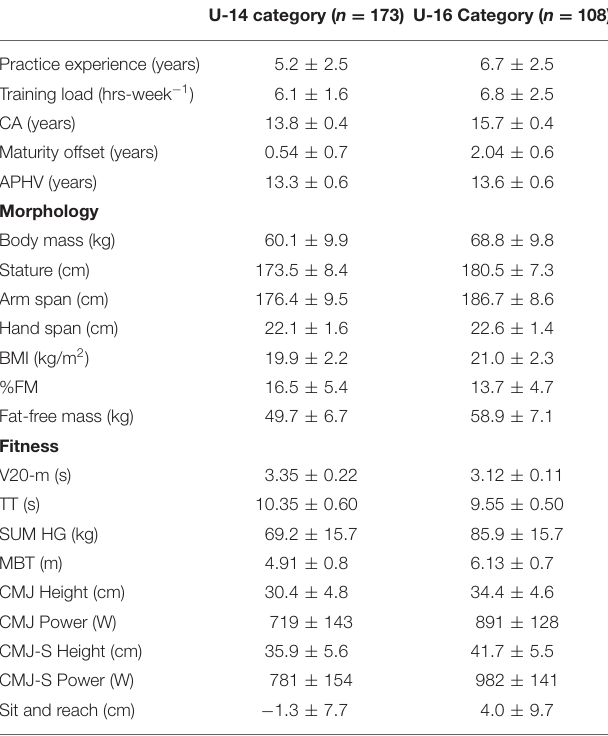
TABLE 2 | Descriptive statistics (mean ± SD) for training experience, maturational parameters, morphological, and fitness characteristics of U-14 and U-16 male players participated in the U-14 Portuguese Basketball Championship for regional